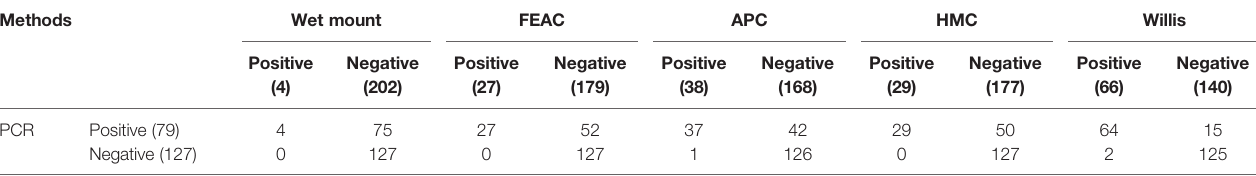
TABLE 2 | Evaluation of the PCR assay in comparison with parasitological methods for the diagnosis of Trichostrongylus spp. infection in stool samples ( n = 206). Methods